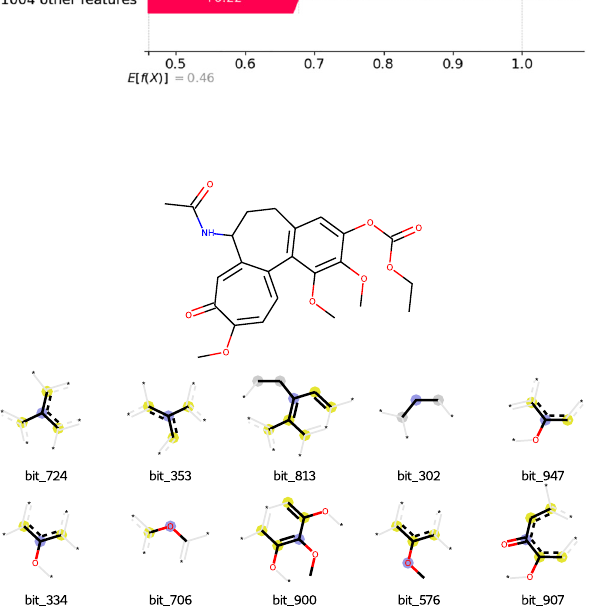
Figure 8: SHAP explanation of the prediction made by the ECFP4 model for sample 537 from the NCI 1 test set, represented as a waterfall plot. Features are ordered by their impact on the model output. Only the top 20 features that contribute the most to the prediction are shown.